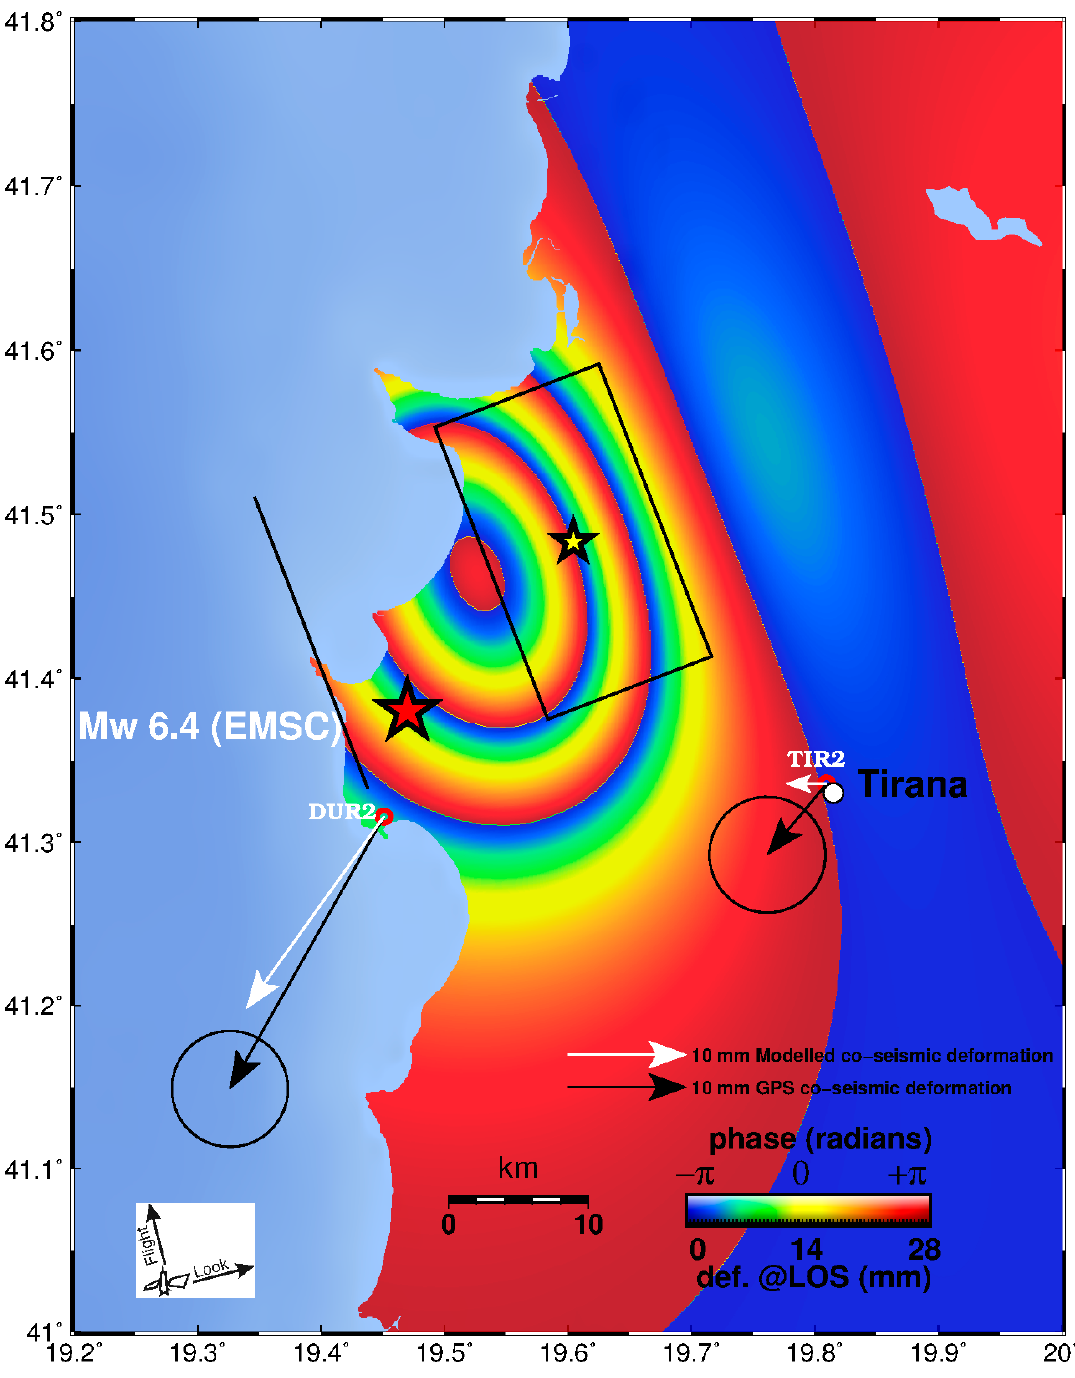
Figure 5. Synthetic interferogram of the ascending track 175 using the fault parameters of Table 4. Yellow star indicates the geodetic centroid. Black rectangle shows the surface projection of the seismic fault. Solid black line indicates projected fault plane intersection (fault trace) at Earth’s surface. The red star indicates the earthquake epicentre (EMSC location). The vector pairs represent the GPS measured (black) and modelled (white) coseismic horizontal displacements at stations DUR2 and TIR2 respectively.